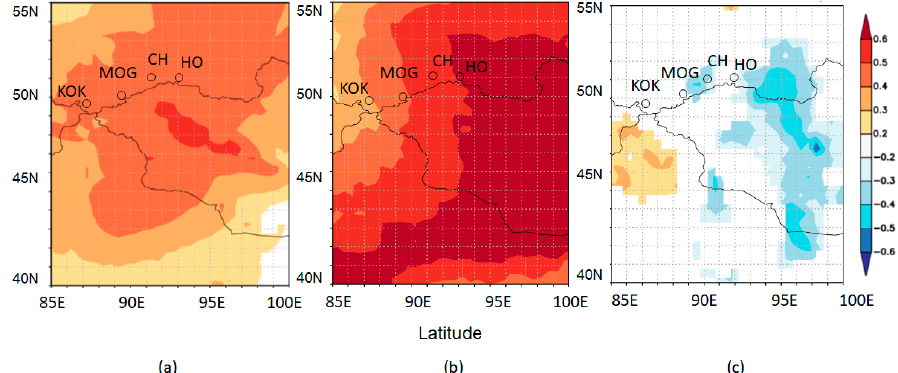
Figure 3. Spatial distribution of correlation coefficients with the p < 0.1 within the range from − 0.6 (dark blue) to + 0.6 (dark red, right vertical scale) between averaged iWUE time series from Koksu (KOK), Mongun (MOG), Ersin (HO) and Chadan (CH), and ( a ) averaged June–August vapor pressure deficit (VPD), ( b ) averaged June–August maximal value of the surface air temperature and ( c ) averaged June–August precipitation calculated for the period from 1919 to 2019.